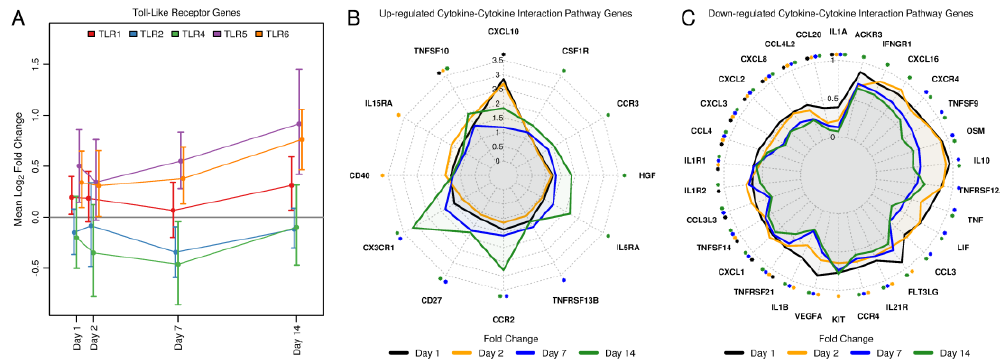
Figure 3. PBMC gene expression responses for Toll-like receptor signaling and cytokine–cytokine receptor interaction pathway genes. ( A ): Mean fold change and associated 95% confidence interval of toll-like receptor genes over time. ( B ): Radar plot of up-regulated DE genes in the cytokine–cytokine receptor interaction pathway. ( C ): Radar plot of down-regulated DE genes in the cytokine–cytokine receptor interaction pathway. Asterisks indicate statistically significant changes that are color coded by